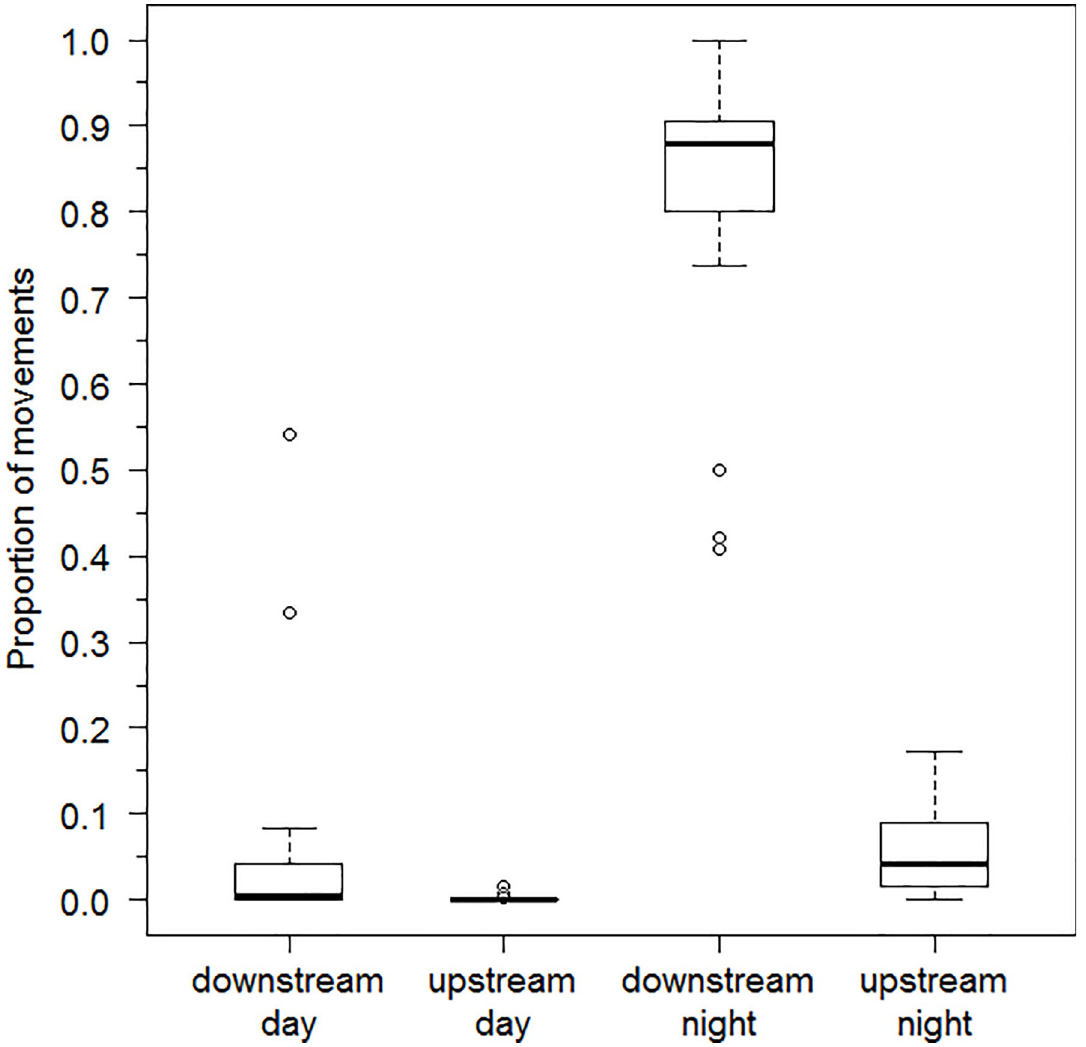
Fig 4. Study III: Direction and timing of movement by juvenile sea lamprey in an artificial stream. Proportion of total movements by newly metamorphosed juvenile sea lamprey (N = 25) that occurred in either the downstream or upstream direction during day or night over a 91 day observation period in an artificial stream, November 6, 2014 –February 2, 2015. Solid horizontal lines show median proportion among fish, boxes show first and third quartiles, whiskers show 1.5 times interquartile range (IQR) from median, and symbols show observations greater than 1.5 IQR from